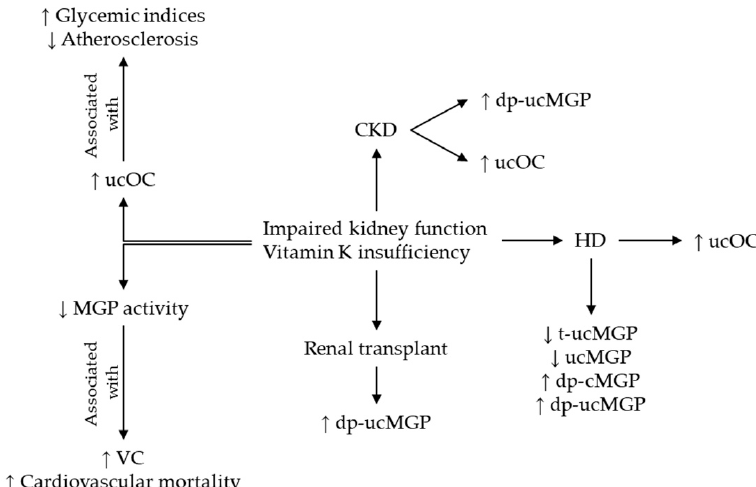
Figure 5. Modification of circulating MGP and OC in CKD. Abbreviations: CKD, chronic kidney disease; OC, osteocalcin, ucOC, uncarboxylated OC; cOC = carboxylated OC; MGP, matrix Gla protein; dp-ucMGP, dephospho-uncarboxylated MGP; t-ucMGP, total-uncarboxylated MGP; ucMGP, uncarboxylated MGP; dp-cMGP, dephospho-carboxylated MGP.